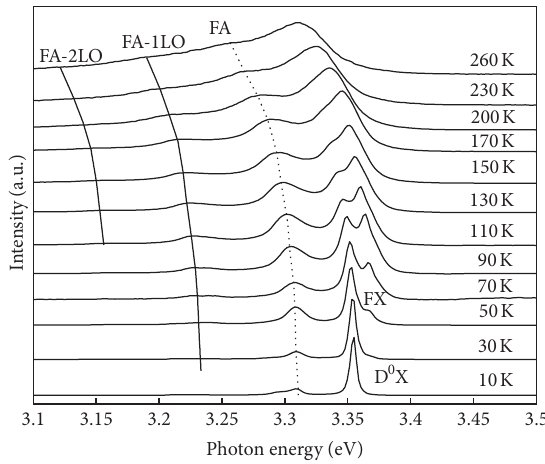
F 3: Temperature-dependent PL spectra of sample A. e spectra were normalized and shied vertically for